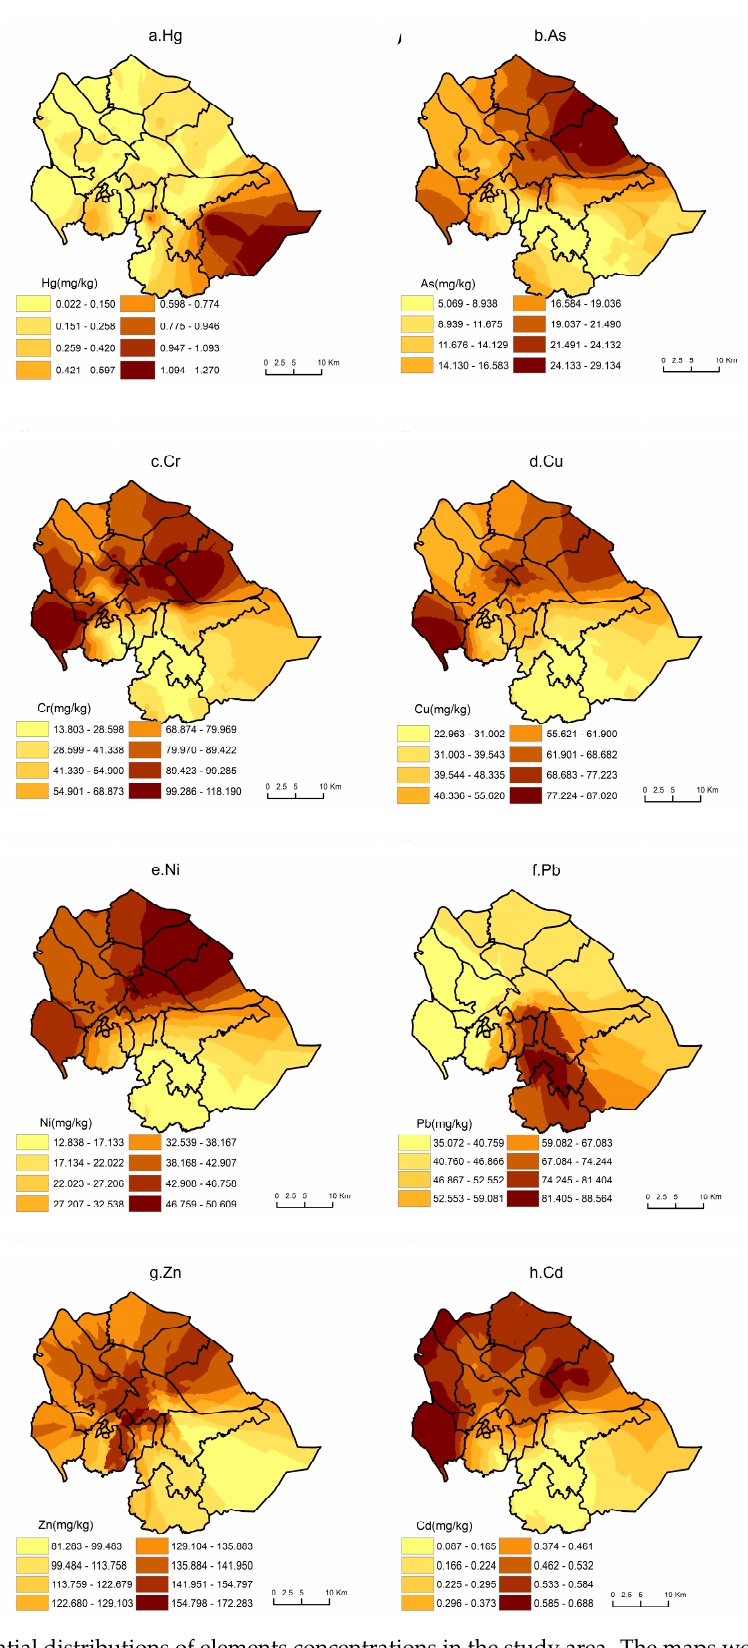
Figure 2. Spatial distributions of elements concentrations in the study area. The maps were generated using ordinary kriging.